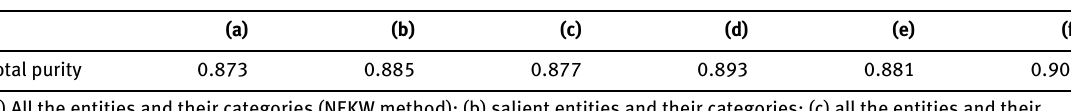
Table 1: Clustering Results on Subset 𝒮 1 Using Original Documents